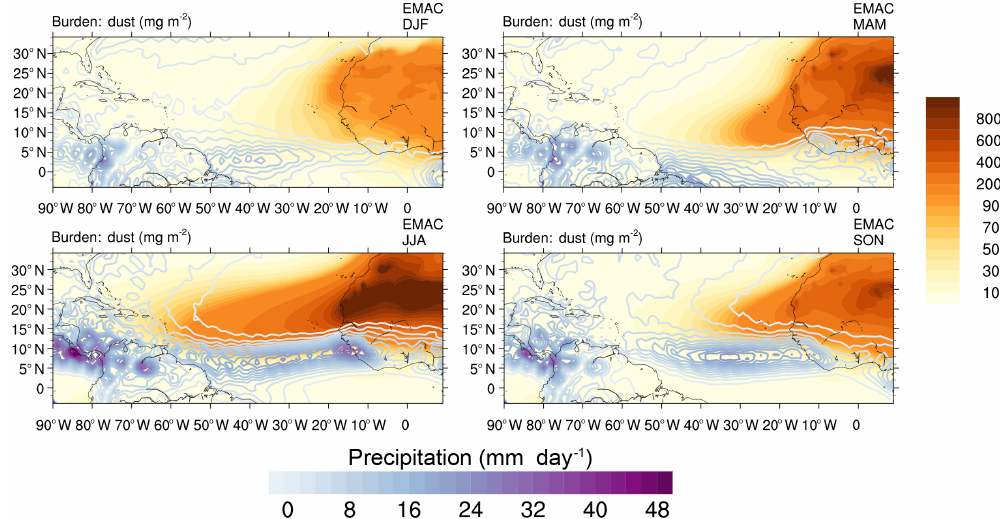
Figure 2. Seasonal averages of the dust burden and precipitation representing the transatlantic dust outflow for the entire model evaluation period (2000–2012). The dust burden and precipitation are at a maximum during the boreal summer and at a minimum during winter. The orange coloring represents the dust burden, while the purple coloring (contour lines) depicts